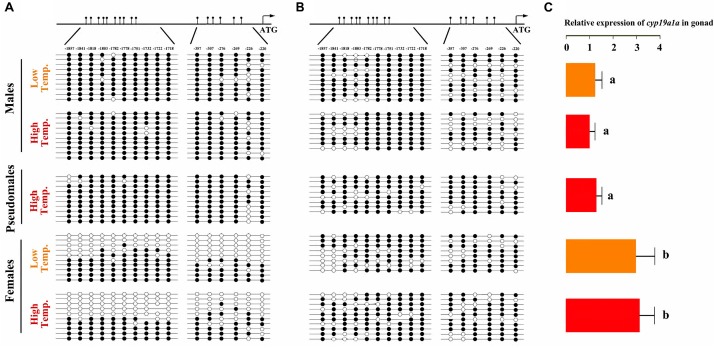
C. semilaevis cyp19a1a promoter methylation levels and correlation with gonad gene expression according to sex and temperature treatment. (A) The methylation patterns of C. semilaevis cyp19a1a promoter in gonads. (B) The methylation patterns of C. semilaevis cyp19a1a promoter in muscle. Numbers indicated CpG positions with respect to the transcription starting site. Open and filled circles denoted unmethylated or methylated positions, respectively, while no circles denoted unknown methylation status due to sequencing problems. Eight to ten clones per fish were analyzed. (C) The relative expression level of C. semilaevis cyp19a1a in gonads by qRT-PCR. The data was shown as mean ± SD (n = 6). Groups with different letters were significantly different (P < 0.05).